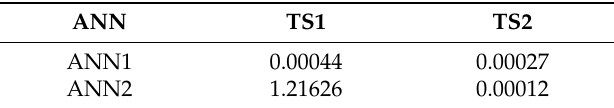
Table 1. Classical ANOVA F-test results obtained for F y* values. Table 3. Classical ANOVA F-test results obtained for d u*